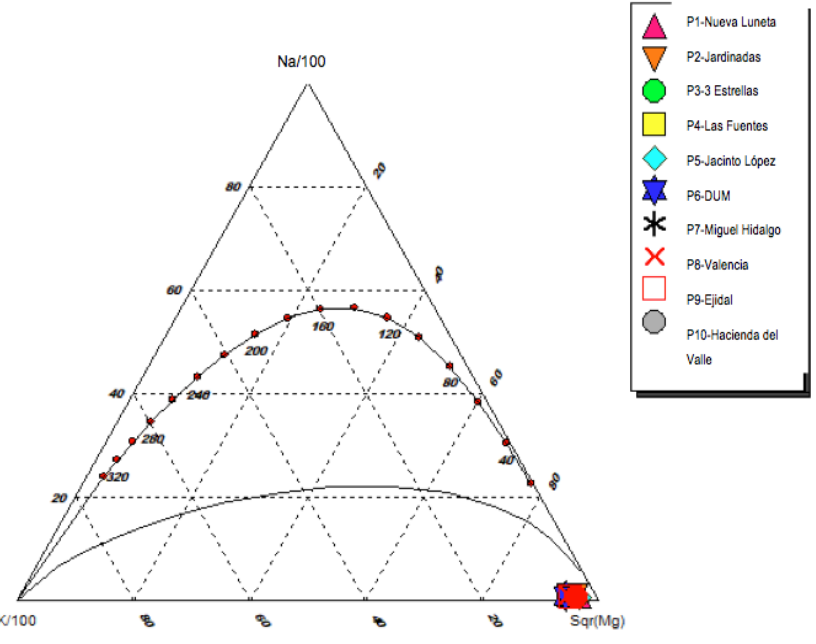
Figure 6. Giggenbach diagram of the studied sites.